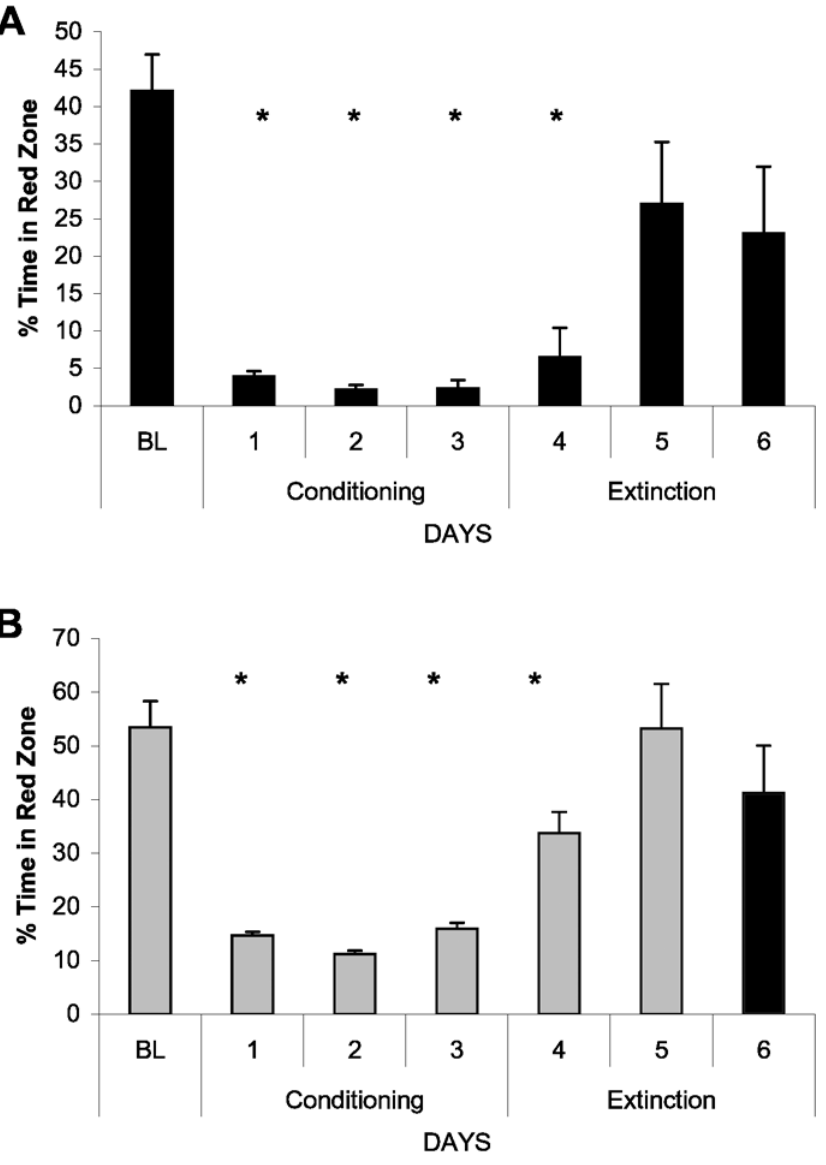
Figure 11. Conditioned place avoidance (CPA) in wild-type young (A) and middle-aged (B) zebrafish. Y-axis: % time spent in the red zone of the test tank at Baseline (BL), during Conditioning and Extinction phases of the study. Conditioning phase: * p , 0.00001 for main group and training day effects; no significant difference between age groups. Extinction phase: between group comparison: p , 0.0003, , 0.0001 and , 0.0001 for day 4, 5 and 6, respectively; within middle-aged group comparison, relative to Baseline, p , 0.01, NS and NS for day 4, 5 and 6 respectively; within young group, p , 0.0001, NS and , 0.02 for day 4, 5 and 6, respectively.